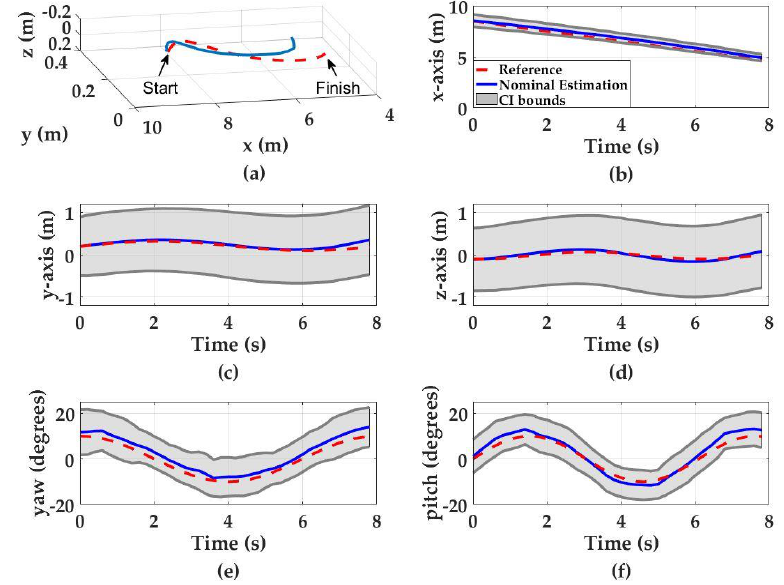
Figure 8. Monte Carlo simulation results for three-dimensional zigzag motion. Red dashed curves denote the UUV motion, blue curves denote the nominal position estimations and the gray regions denote the 95% confidence interval. ( a ) The UUV trajectory in zigzag motion (3D space); ( b ) x -axis estimations; ( c ) y -axis estimations; ( d ) z -axis estimations; ( e ) yaw estimations; and ( f ) pitch estimations.